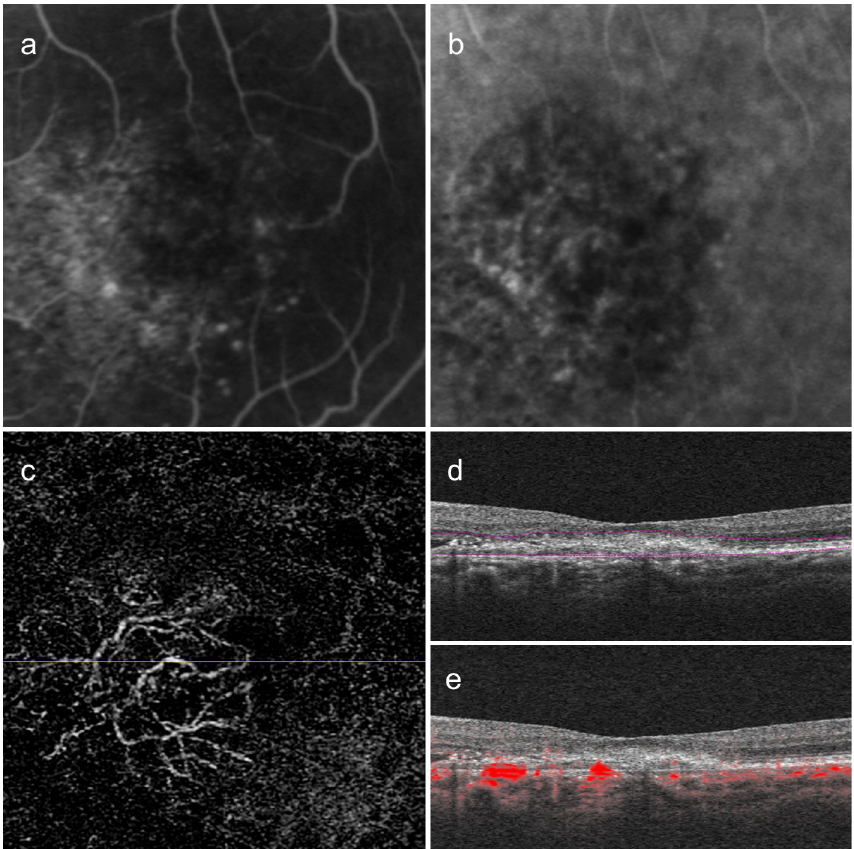
Fig 2. A case of Type 1 choroidal neovascularization. Left eye images of a 74-year-old woman with a visual acuity of 20/32. (a) Mid-phase fluorescein angiography showing leakage from an undetermined source. (b) Indocyanine green angiography showing a neovascular membrane. (c) 3 × 3-mm en face optical coherence tomography angiography (OCTA) images after removal of projection artifacts. The vessel branches radiate in all directions from the center of the lesion (medusa pattern). Note that the central vessels show trunk-like vessels. (d and e) Corresponding B-scan images showing segmentation lines (d) and flow signals overlaid on the B-scan image (e).